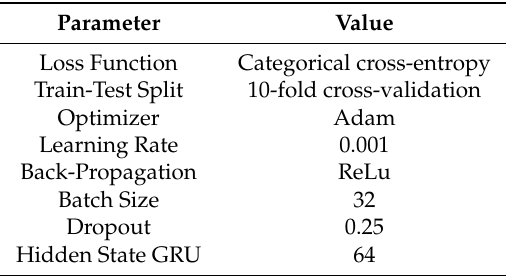
Table 3. The values of all